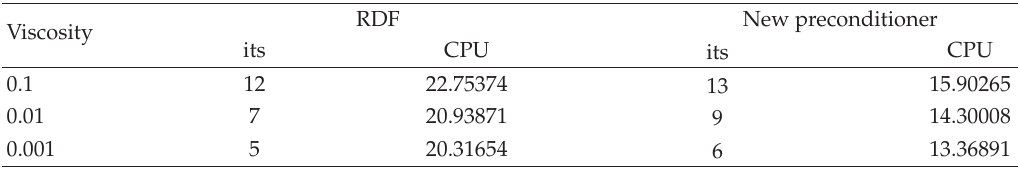
Table 5: Iterations of preconditioned GMRES (cid:4) 30 (cid:5) for generalized Oseen problem (cid:4) Picard, Q2-Q1, 128 × 128 uniform grids (cid:5) .